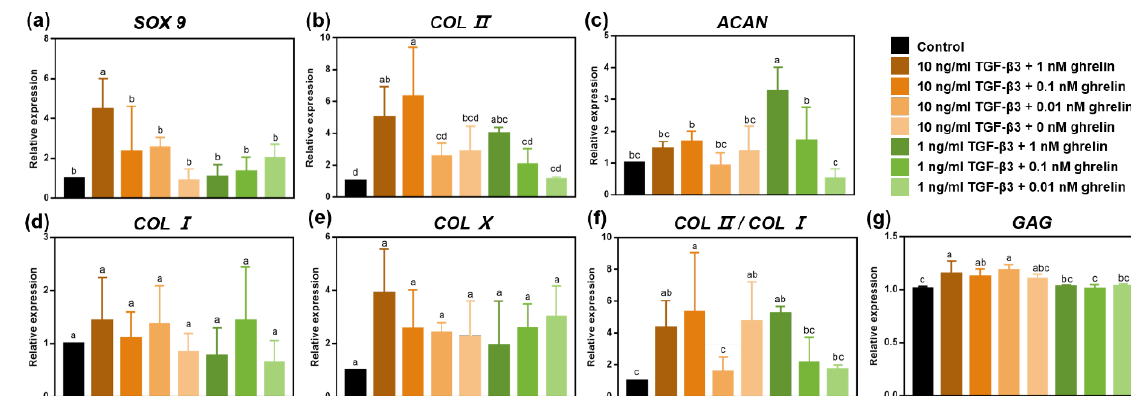
Figure 7. Effects of combinations of different concentrations of TGF- β 3 and ghrelin on the chondrogenic differentiation of hMSCs. qRT-PCR analyses of SOX9 ( a ), COL II ( b ), ACAN ( c ), COL I ( d ), COL X ( e ), and COL II/COL I ( f ) expression and on the quantification of GAG ( g ) were conducted after 21 days of chondrogenic differentiation with different concentrations of TGF- β 3 and ghrelin. Statistical significance was marked with different letters ( p < 0.05). Abbreviations: SOX9, Sry-type high-mobility-group box 9; COL II, Type II collagen; ACAN, Aggrecan; COL I, Type I collagen; COL X, Type X collagen; GAG, glycosaminoglycan.